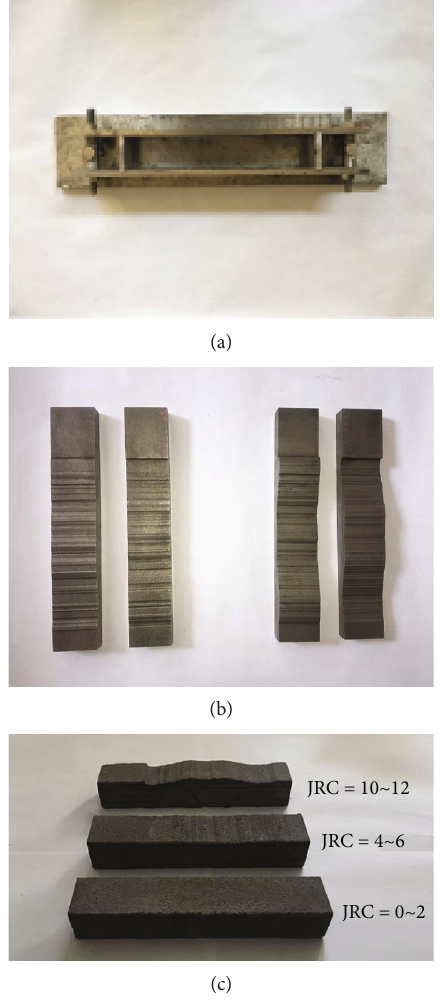
Figure 1: Preparation of core specimens: (a) core specimen mould, (b) rough surface mould, and (c) rough surface specimens.